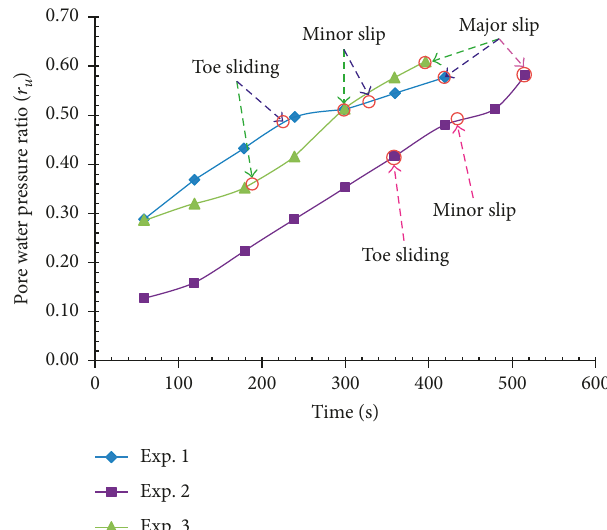
Figure 13: Pore water pressure ratio against time.